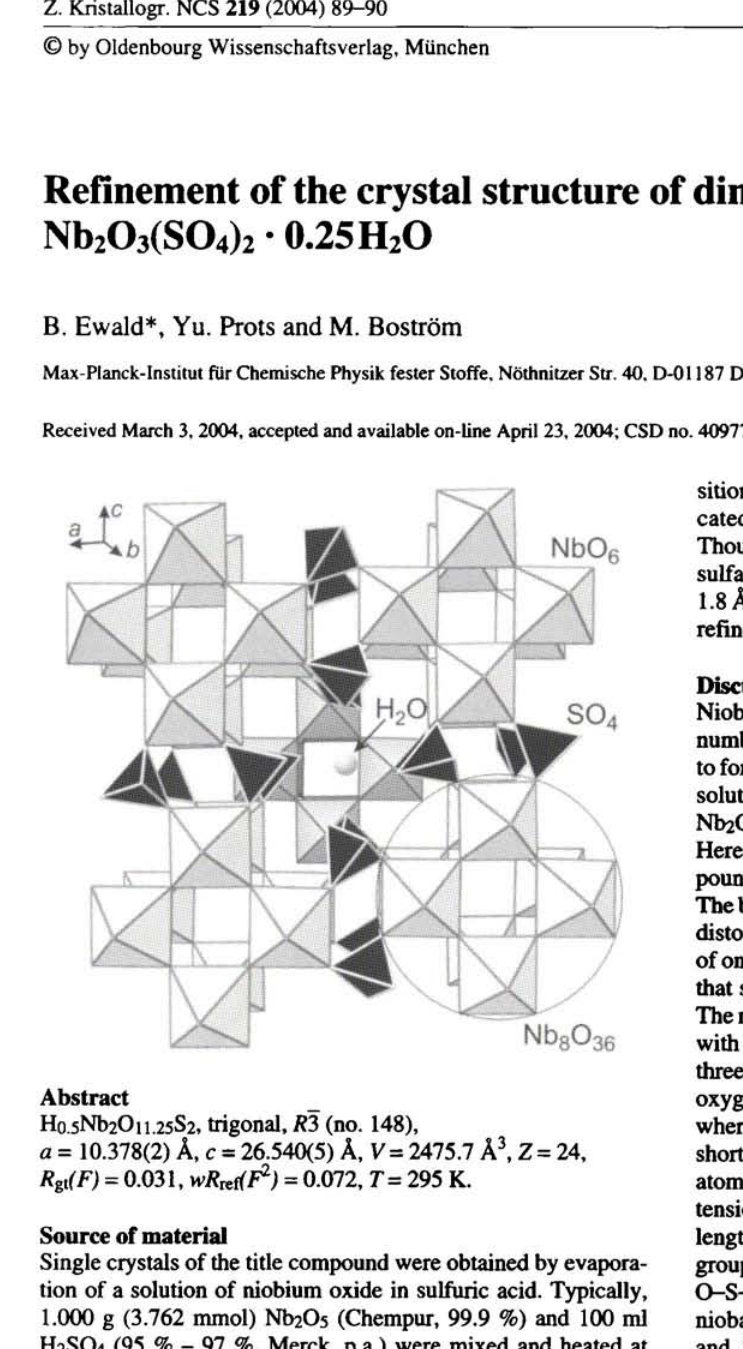
Table 1. Data collection and handling.